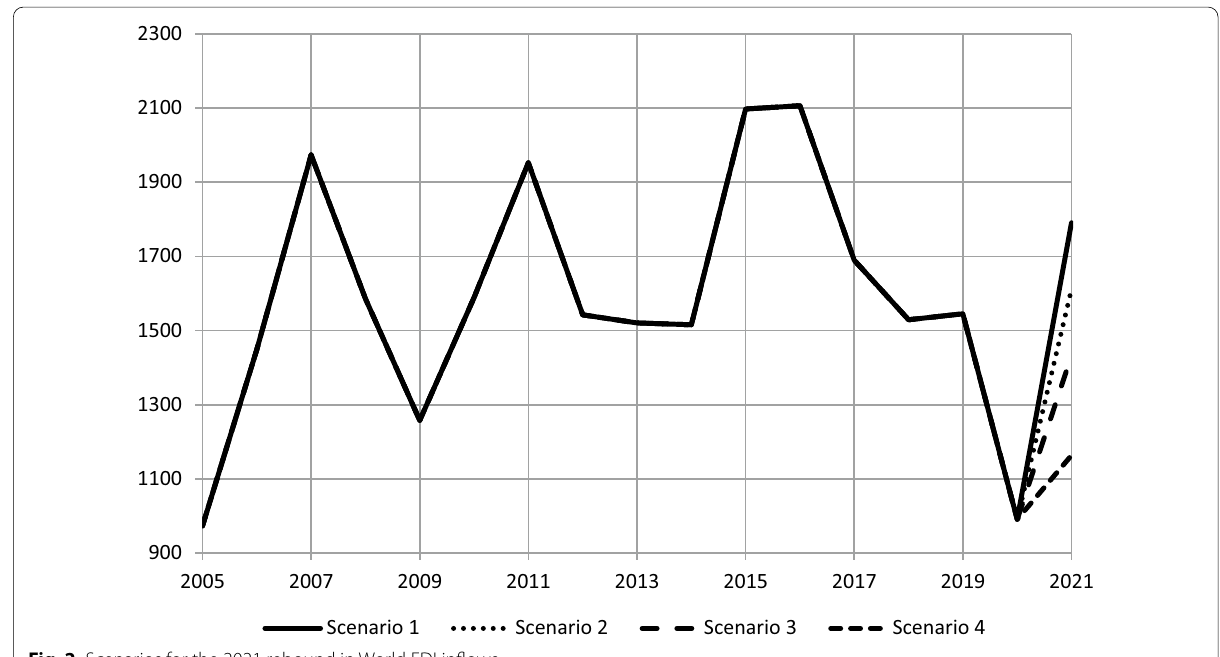
Fig. 2 Scenarios for the 2021 rebound in World FDI